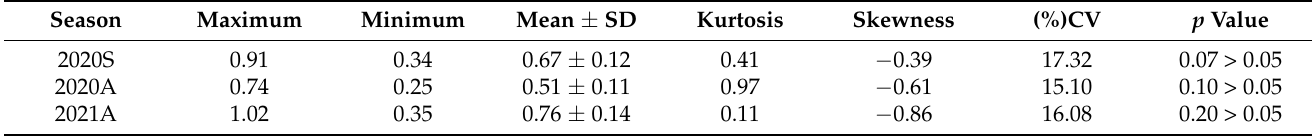
Table 1. Statistical analysis of the cucumber stem diameter.